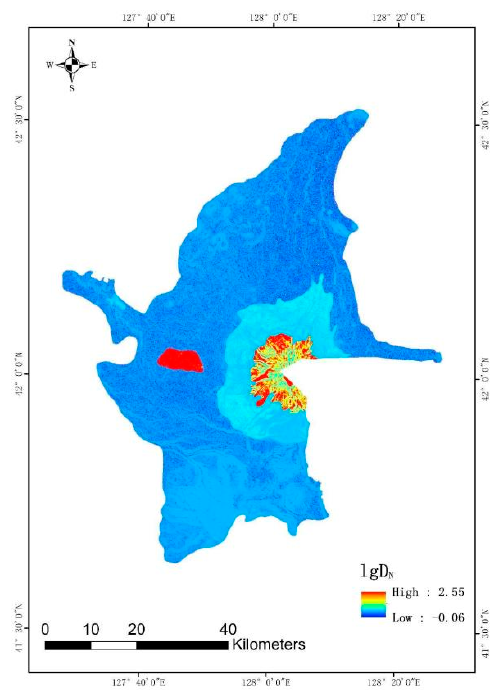
Figure 6. Cumulative